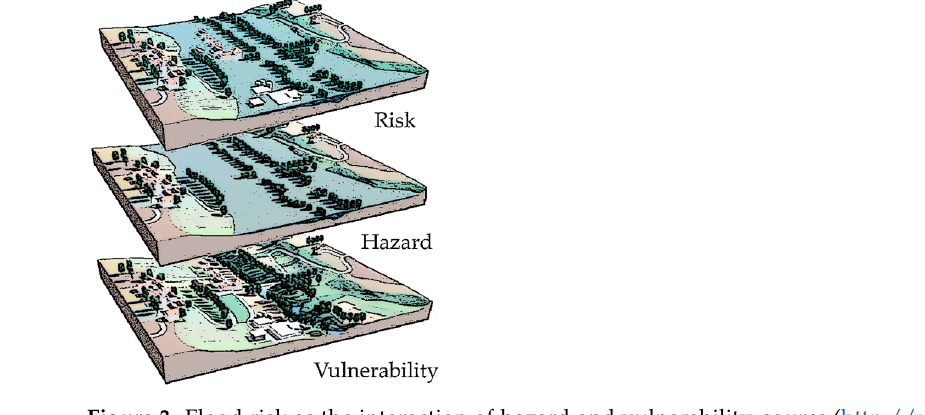
Figure 3. Flood risk as the interaction of hazard and vulnerability, source:(http://www.prim.net, accessed on 1 September